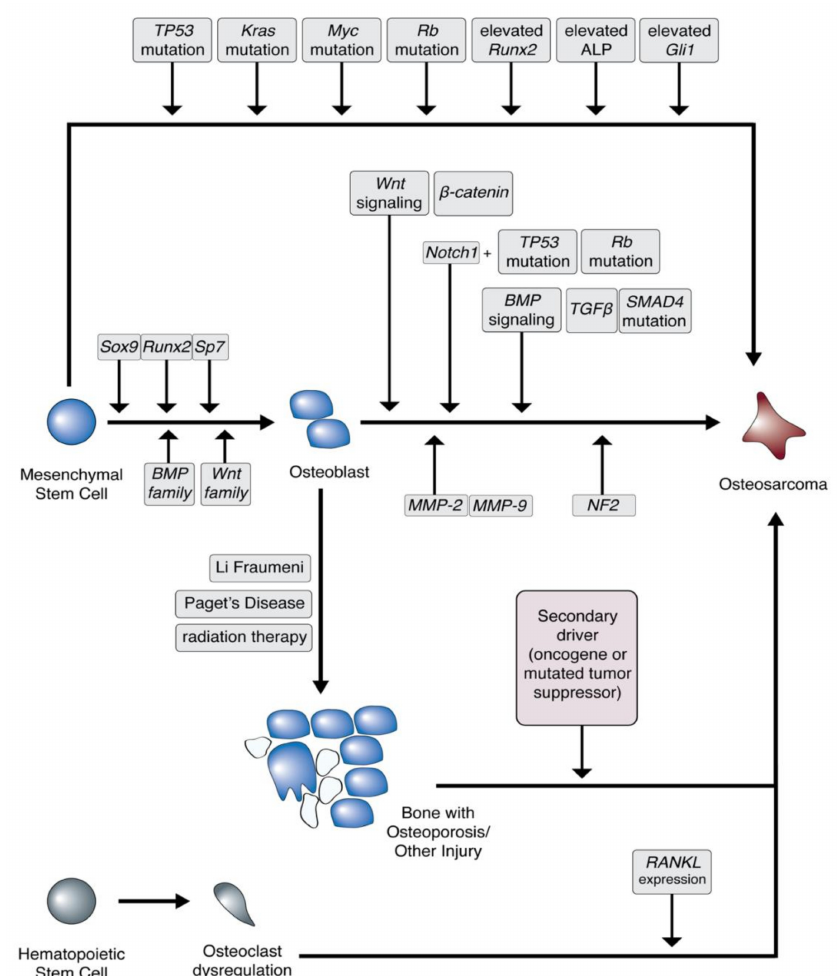
Figure 2. Overexpression of certain transcription factors and oncogenes and dysregulation of tumor suppressor genes can drive osteosarcoma development. TP53: tumor protein p53; Rb: retinoblastoma; Runx2: Runt-related transcription factor 2; ALP: alkaline phosphatase; Gli1: glioma-associated oncogene homolog 1; Sox9: SRY-box transcription factor 9; Sp7: osterix; BMP: bone morphogenic protein; Wnt: wingless and int-1; TGF β : transforming growth factor-beta; SMAD4: Mothers against decapentaplegic homolog 4; MMP: matrix metalloproteinase; NF2: neurofibromatosis-2; RANKL: receptor activator of nuclear-factor kappa B